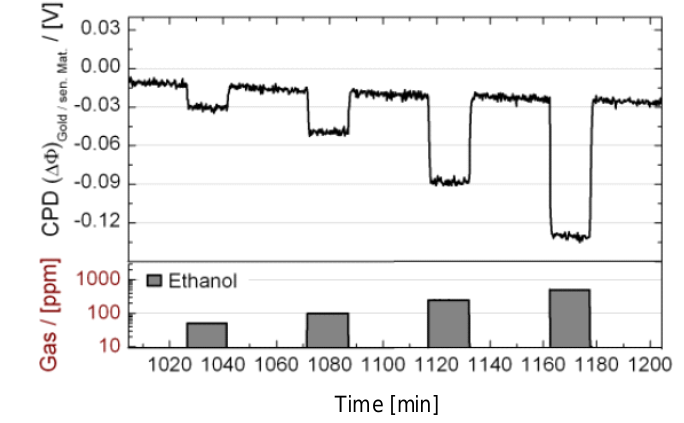
Figure 16. Reaction of a porous Ga 2 O 3 thick film at room temperature in wet synthetic air to ethanol. No signal to reactive small hydrocarbons (ethane, ethene, ethine, propane mixture) in the range of 1,000 ppm is observed.